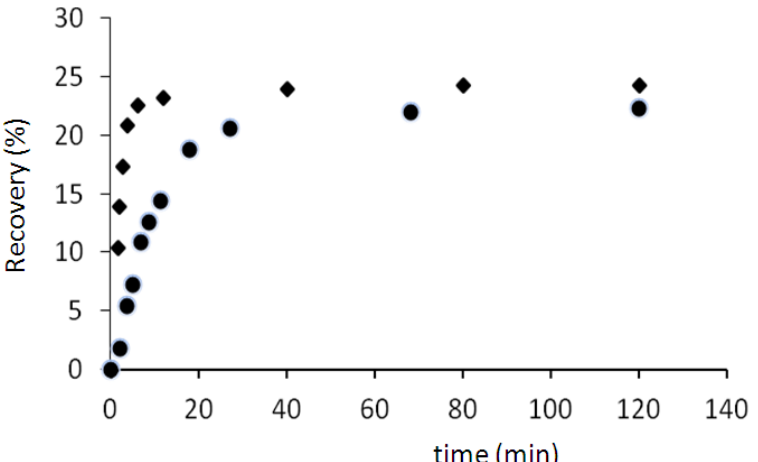
Figure 7. Recovery tests at 70 °C (●) and 75 °C